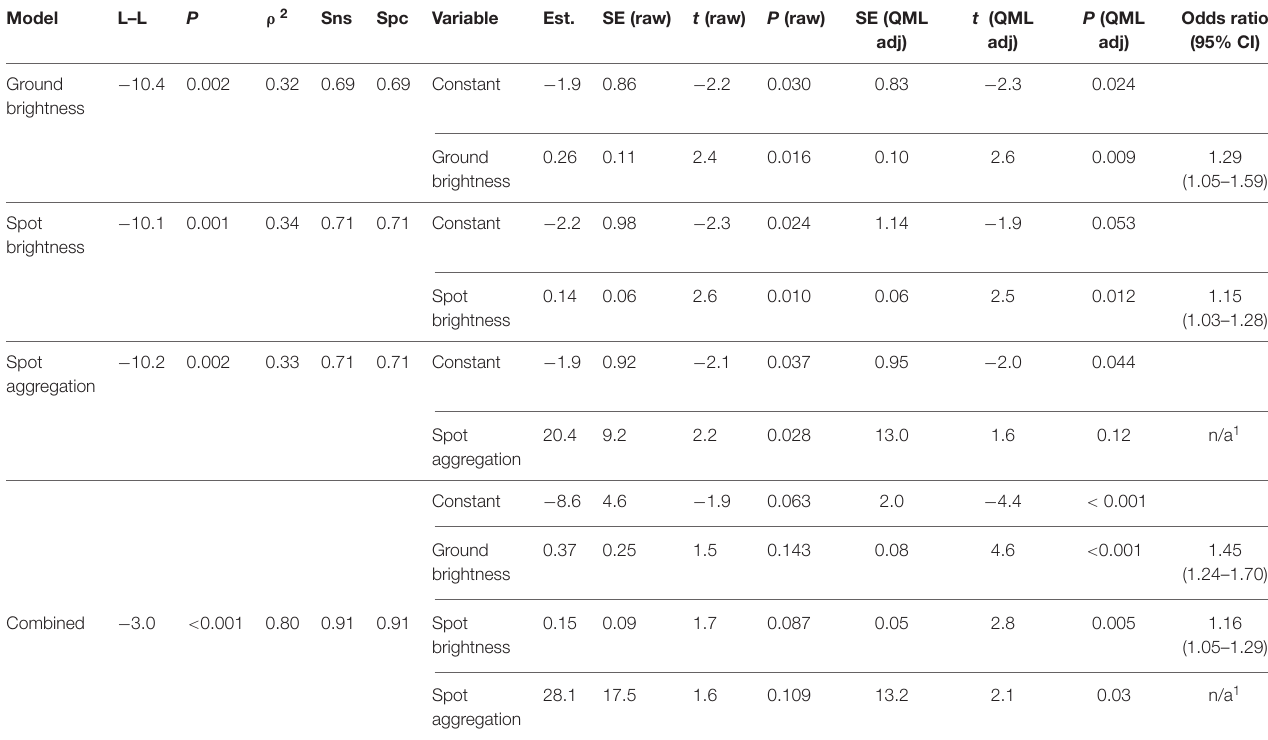
TABLE 2 | Logistic regression models of the rejection of foreign eggs by Rüppell’s weaver. Model